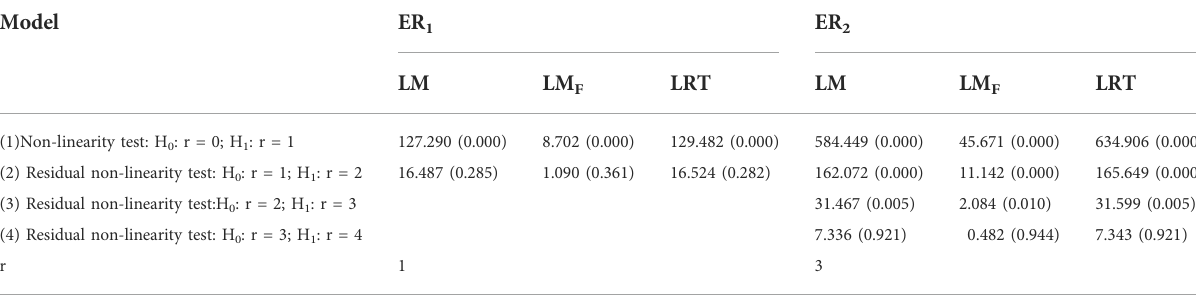
TABLE 12 Non-linearity test